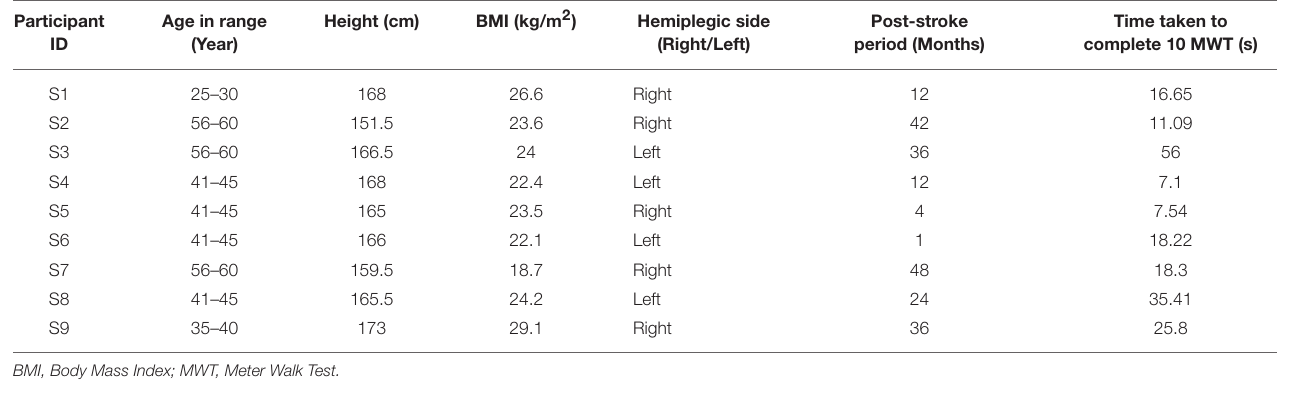
TABLE 2 | Participant characteristics for Stage 3 of study.